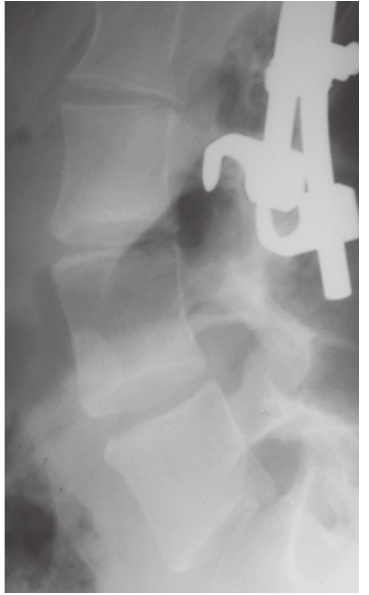
Figure 1: Radiography of the lumbal spine demonstrating osteosynthetic material until the border of